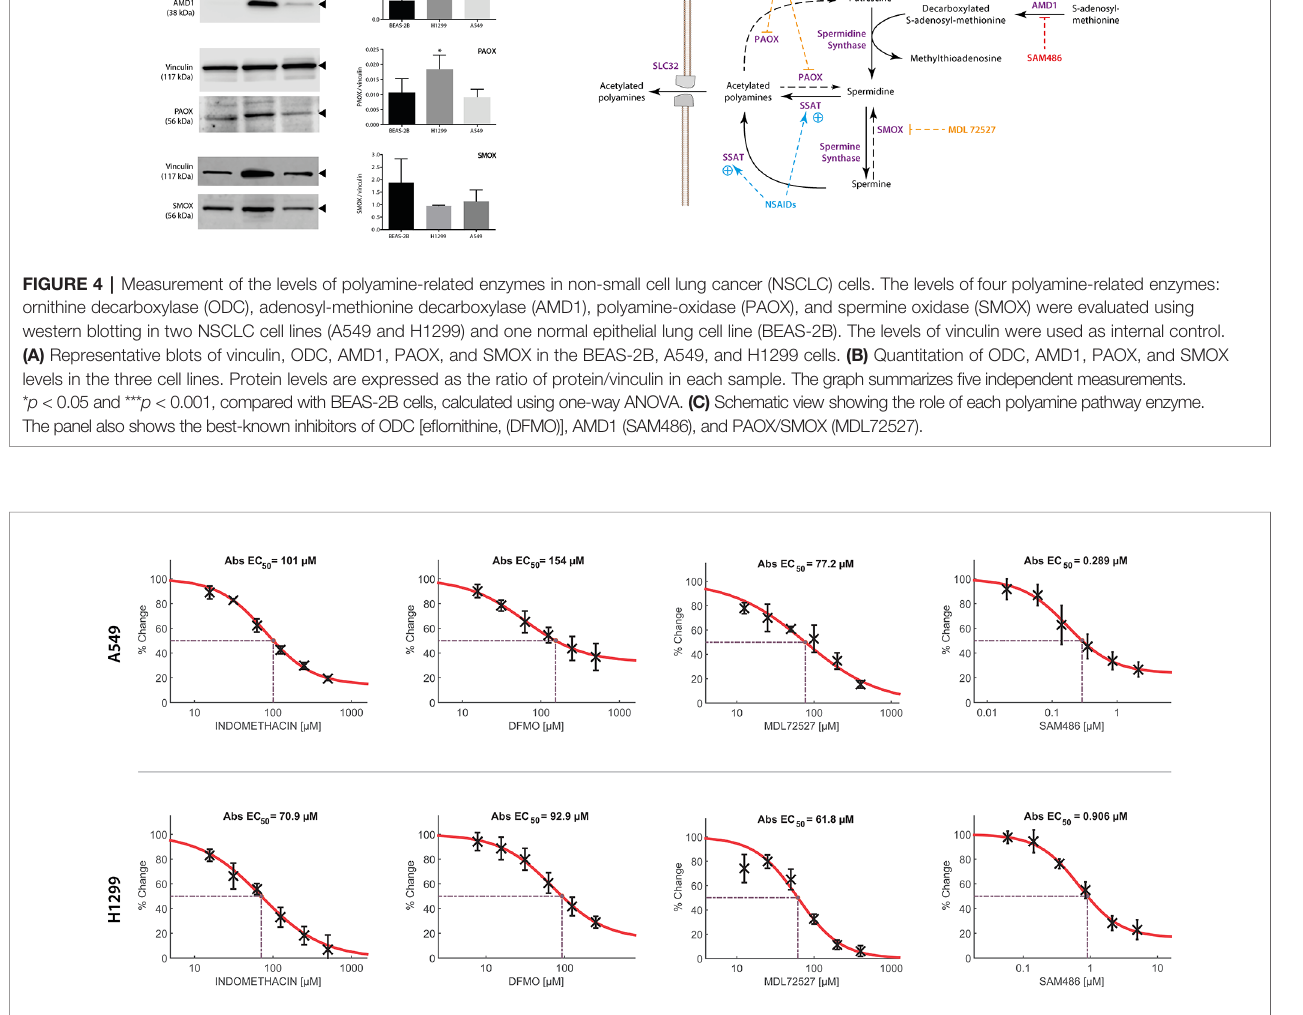
FIGURE 5 | Concentration-response curves of indomethacin, e fl ornithine (DFMO), MDL72527, and SAM486 for the viability of non-small cell lung cancer (NSCLC) cells. The effects of indomethacin, DFMO, MDL72527, and SAM486 on cell viability were measured using the 3-(4,5-dimethylthiazol-2-yl)-2,5-diphenyltetrazolium bromide (MTT) assay. Two NSCLC cell lines were used: A549 (upper row) and H1299 (lower row). Cells were exposed to different drugs for 96 h. Data were loaded in the Combene fi t software to plot concentration-response curves and combination studies ( Figure 6 ). “ Abs EC 50 ” indicates the concentration that reduced cell viability by 50%, normalized using control data. Data summarize the results of four independent